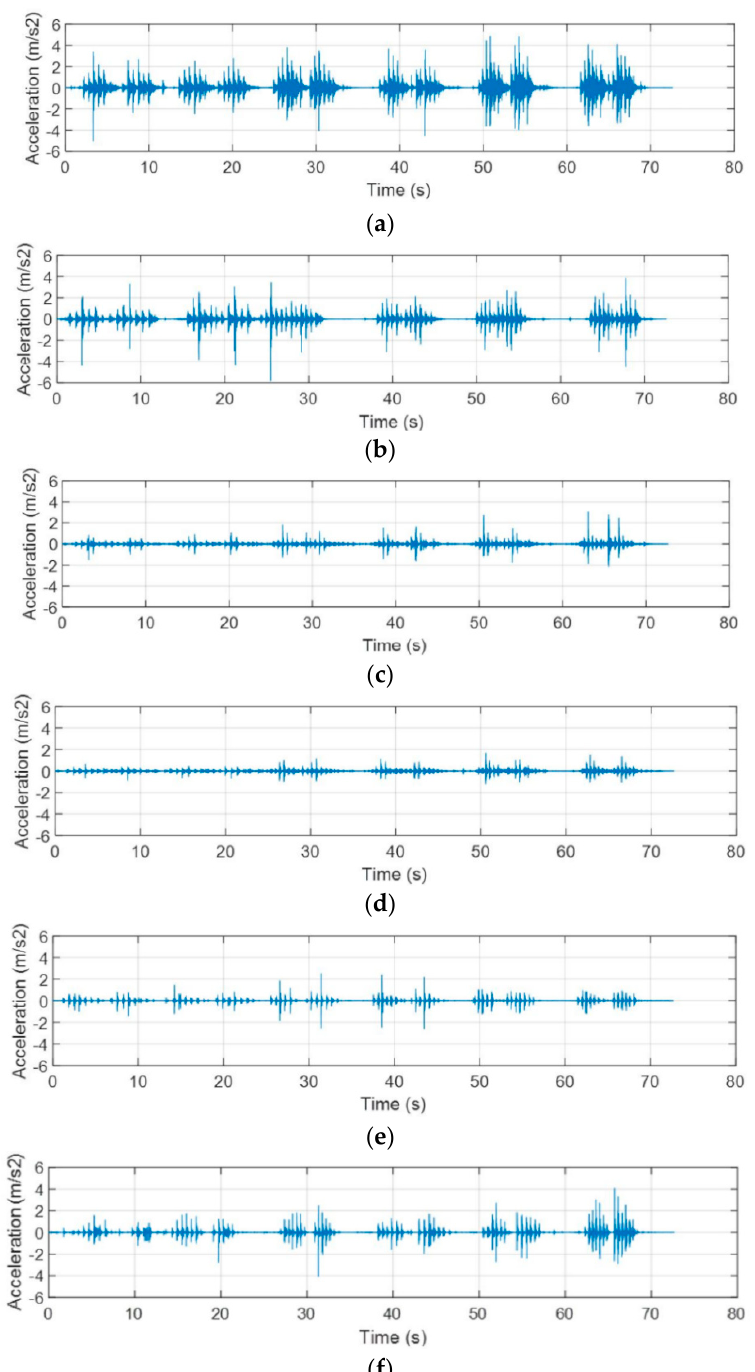
Figure 10. Typical responses for laboratory and in-situ floors: ( a ) Lab-3.0-W; ( b ) Lab-3.0-S; ( c ) Lab-2.1-W; ( d ) Lab-21-S; ( e ) Field-2.4-W; ( f ) Field-3.1-W.